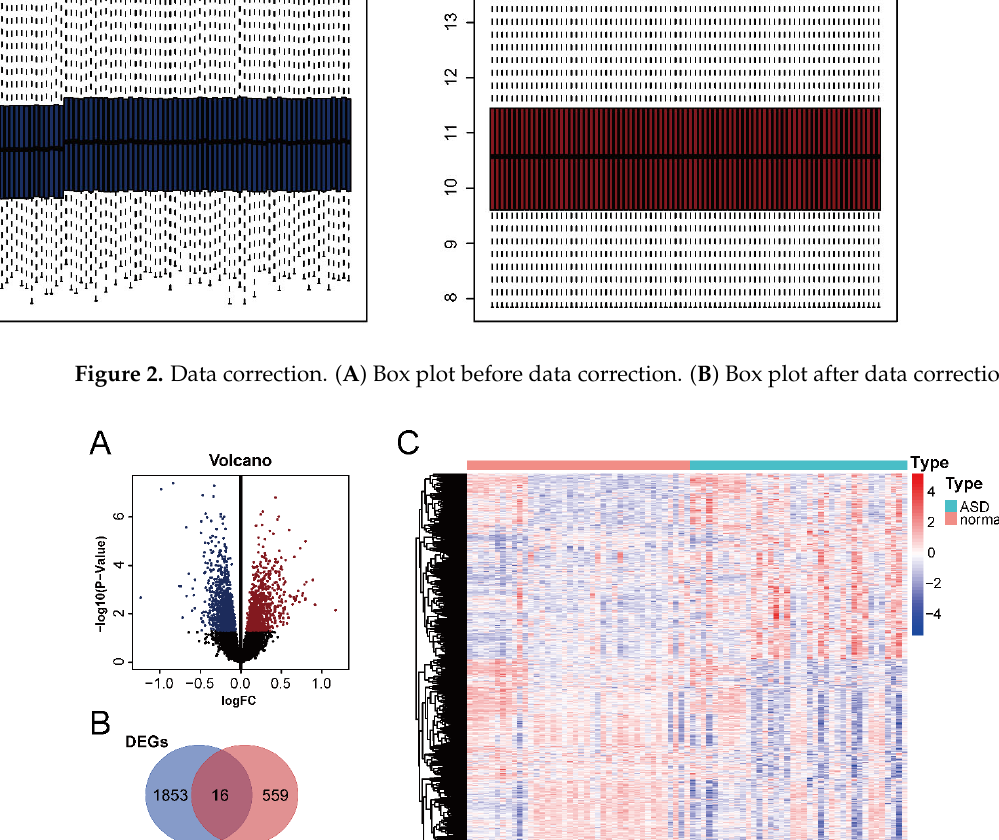
Figure 3. Identification of DEGs in ASD and ASD sensory perception abnormality ‐ related genes. ( A ) Volcano plot of DEGs in ASD. The red color represents up ‐ regulated genes, and the blue color represents down ‐ regulated genes. ( B ) Venn diagram of DEGs in ASD and sensory perception genes. ( C ) Heatmap of DEGs in ASD. Red indicates the upregulated genes, and blue indicates the down ‐ regulated genes.